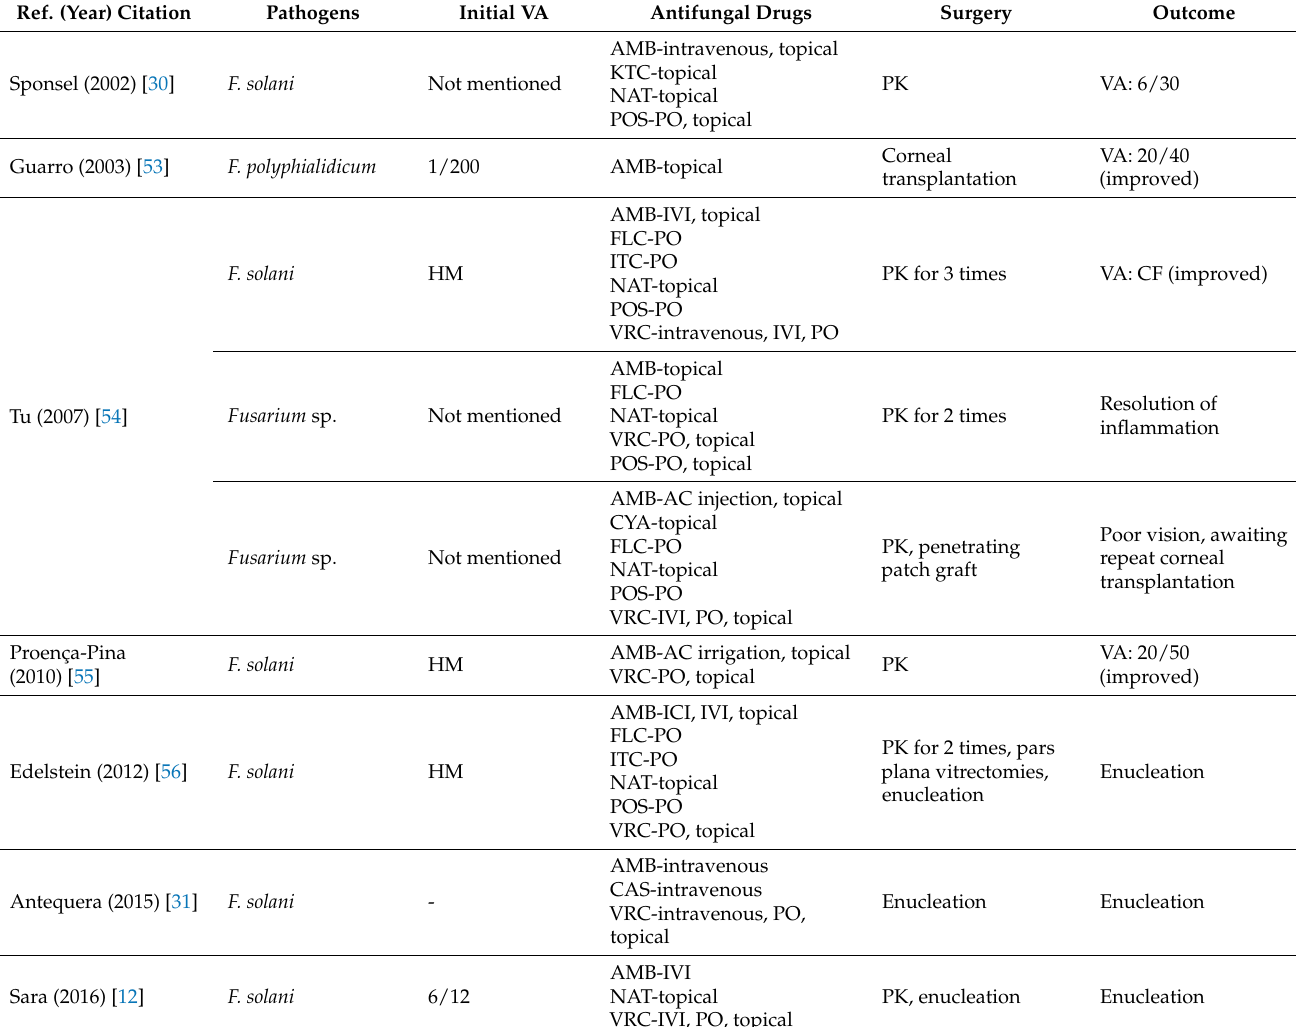
Table 1. Outcomes of case reports affected by multidrug resistant fungal